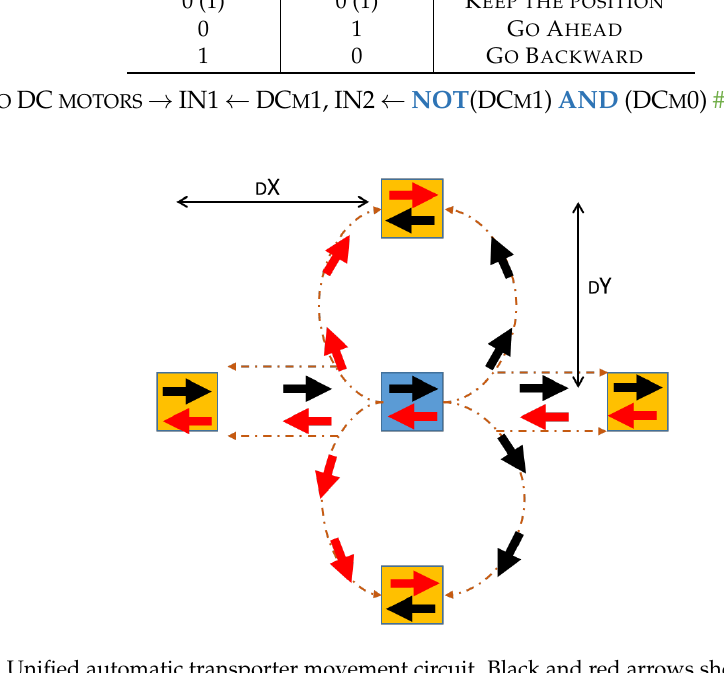
Figure 7. Unified automatic transporter movement circuit. Black and red arrows show all the available direction starting from a specific initial position (blue square).